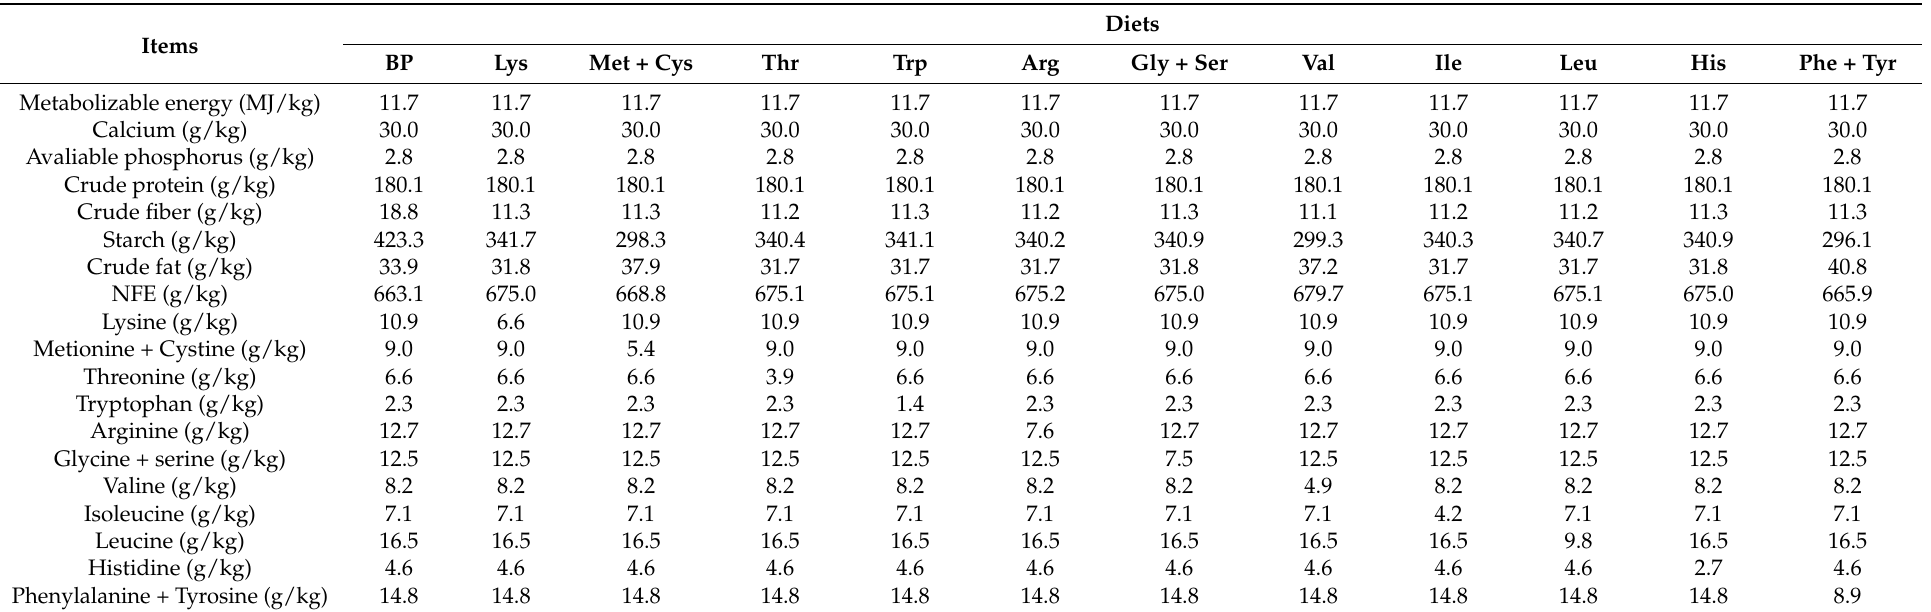
Table 3. Nutritional levels of amino acids in experimental